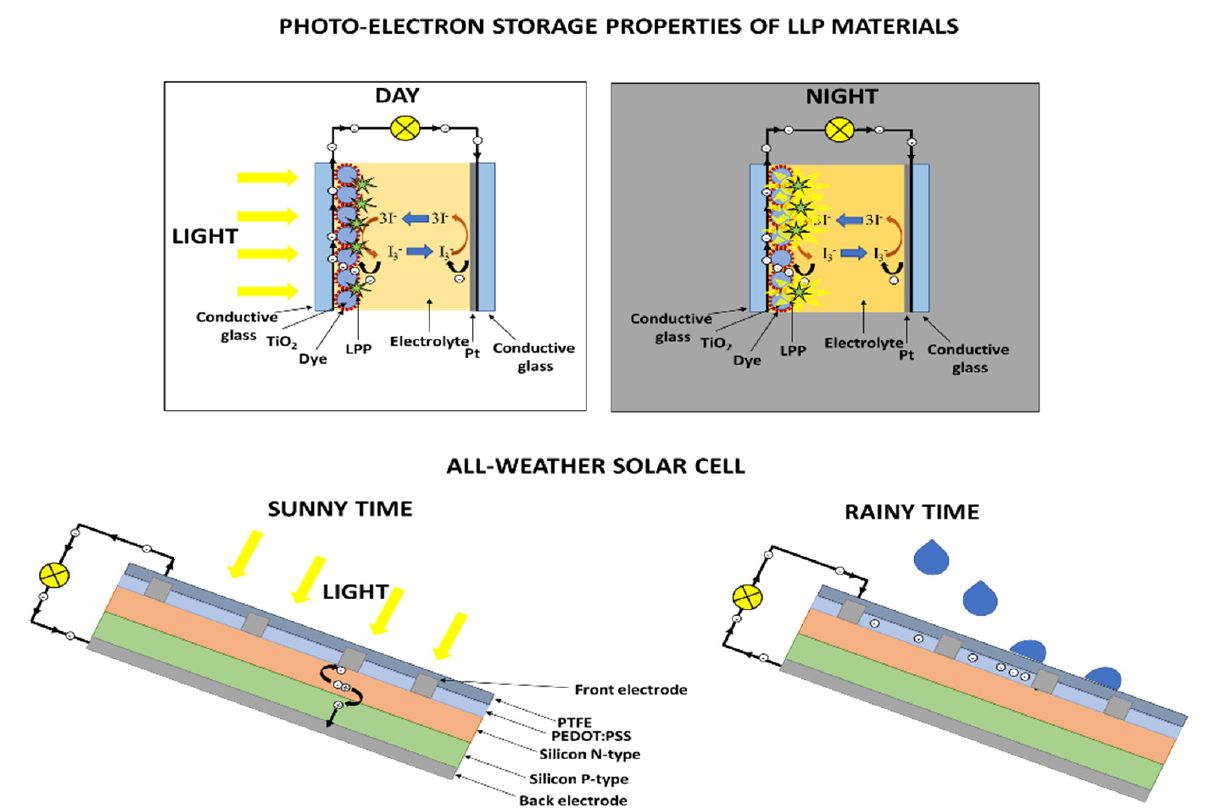
Figure 1. The principle of operation of DSSC and silicon solar cells ( A ) and graphical representation of above mentioned co-harvesting systems ( B ).